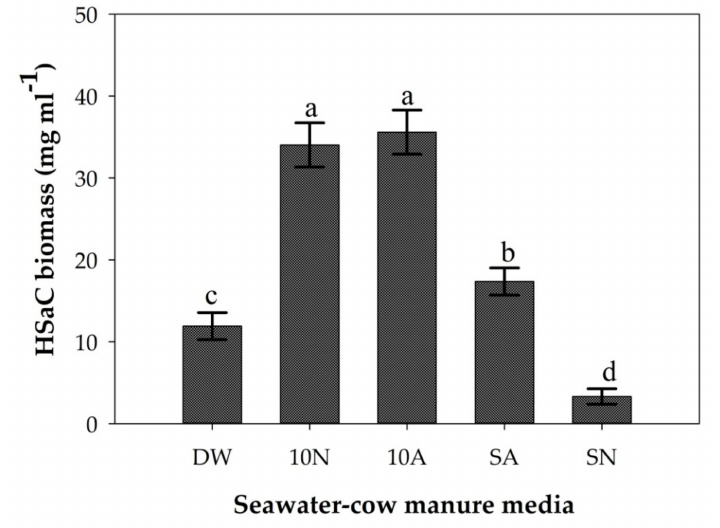
Figure 6. E ff ect of both natural and artificial seawater in cow manure media on HSaC cyanobacterial biomass. DW = distilled water with cow manure, 10N = natural seawater (EC, 10 dS / m) with cow manure, 10A = artificial seawater (EC, 10 dS / m) with cow manure, SA = artificial seawater with cow manure and SN = natural seawater with cow manure. The error bars represent standard deviation (SD). The data are the mean of three replicates. Di ff ering letters indicate significant di ff erences in means of HSaC cyanobacterial biomass in pairwise comparisons (Tukey’s test p < 0.05) for each treatment by LSD.